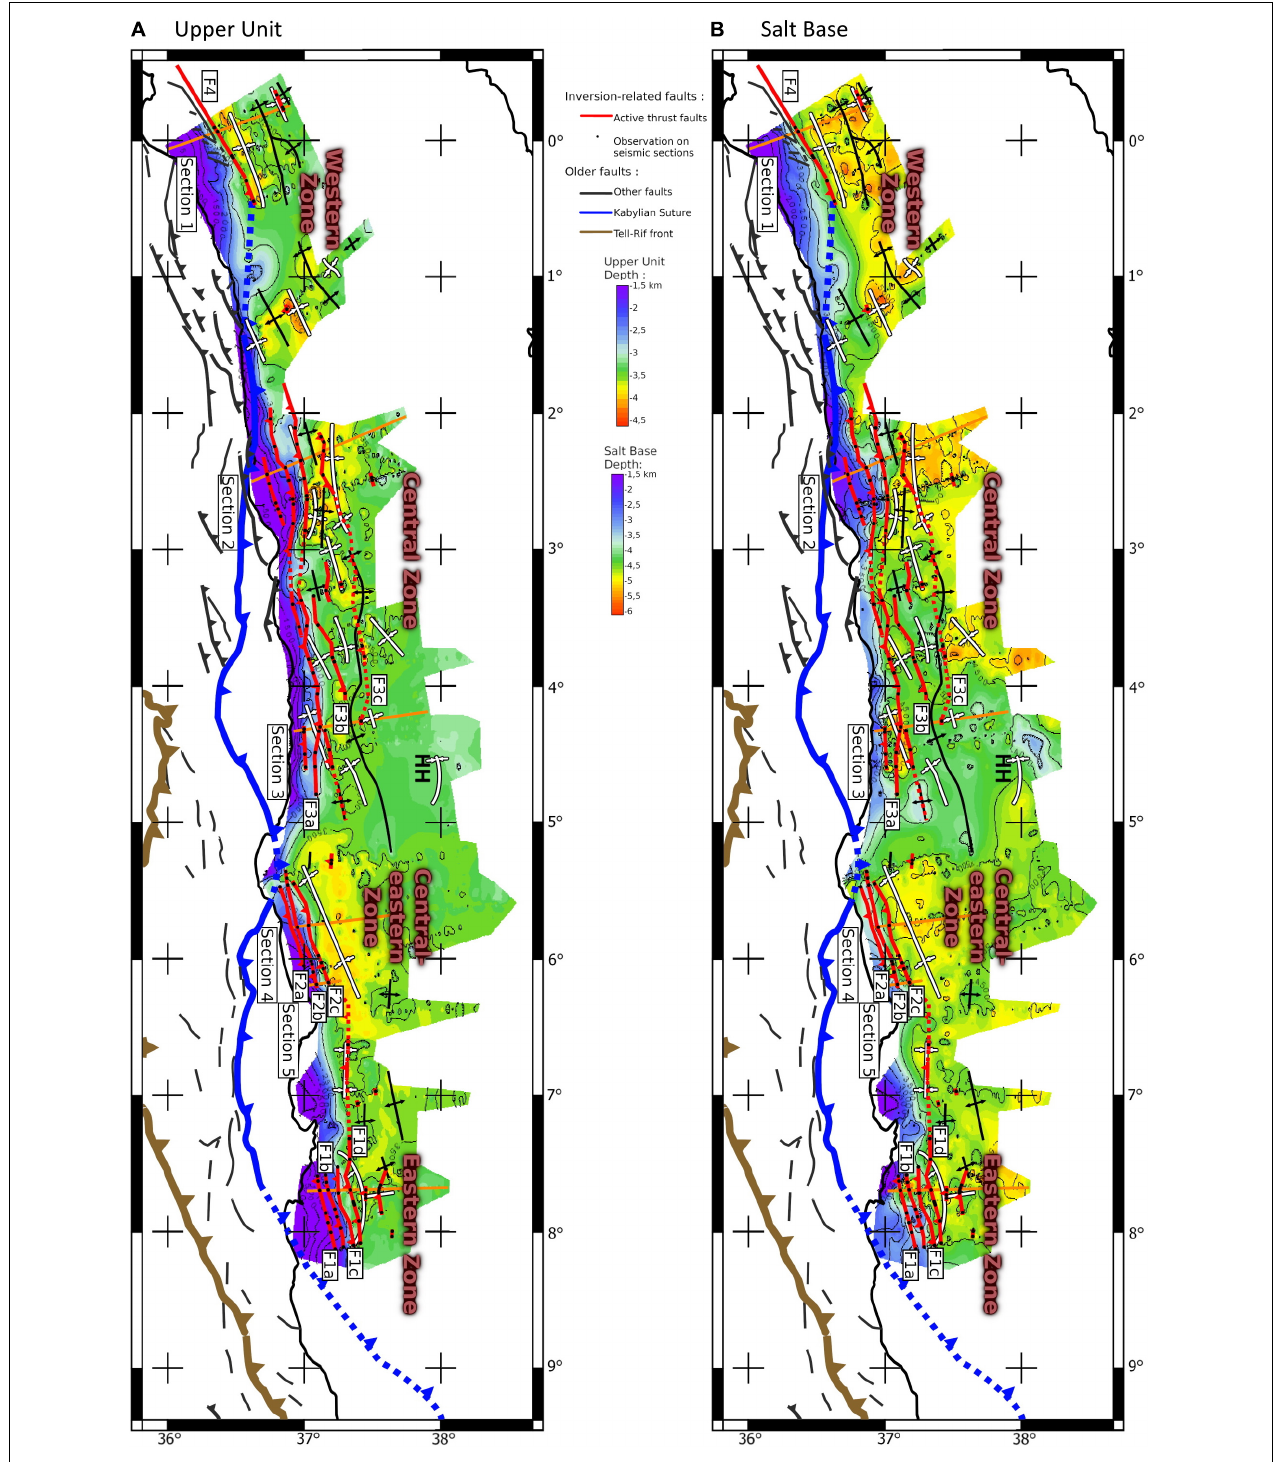
FIGURE 9 | Interpolated depth map of (A) upper unit top and (B) Mobile Unit base in the offshore domain. Main geological limits and active or inherited faults are plotted. Active thrust faults mapped here result from interpolation between the black dots which locate the direct or indirect imaging of faulting activity (close to the top of the basement) on seismic sections. In (A,B) , fault segments with the highest density of black dots are considered as the most reliable and are shown as continuous lines, while other segments are interpolated on longer distances and are shown as dotted curves (see text for details). HH marks the position of the Hannibal